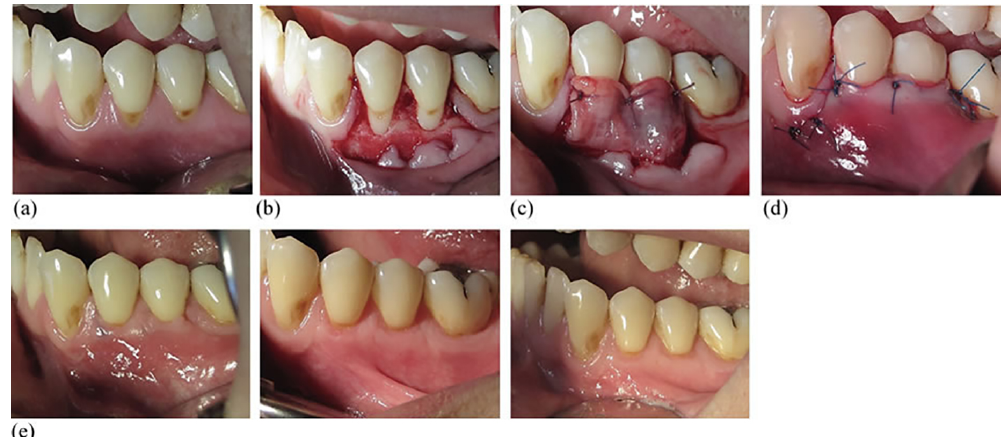
Figure 2- Test group. (a) Preoperative view. (b) Flap design and vertical incisions. (c) CGF placement. (d) CAF and sutures. (e) First, third and sixth months postoperative view. CGF. concentrated growth factor; CAF. coronally advanced